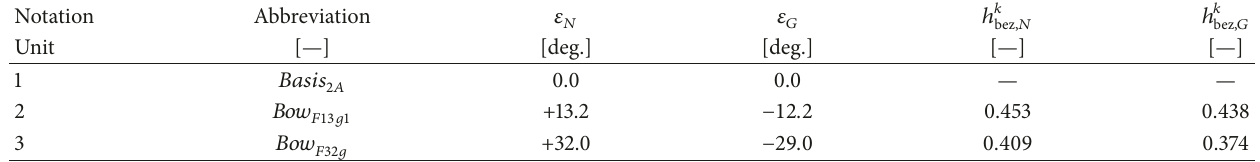
Table 2: Geometrical data of the investigated guide vanes.